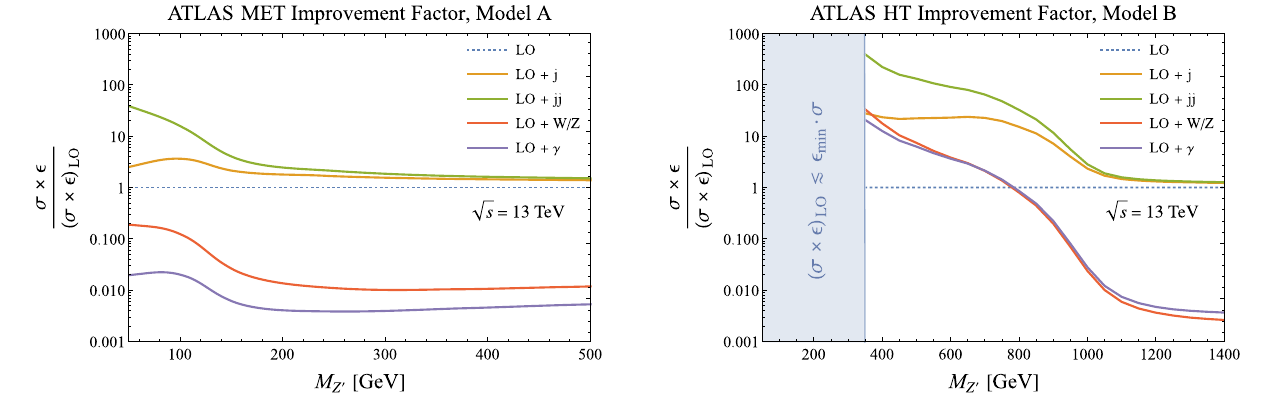
dark pion lifetime of 5 mm. The dotted line is the leading order process. On the right plot, the blue region on the left has zero of events that we simulated pass the trigger and thus an efficiency (cid:18) (cid:2) (cid:18) min = 1 / 400 ,